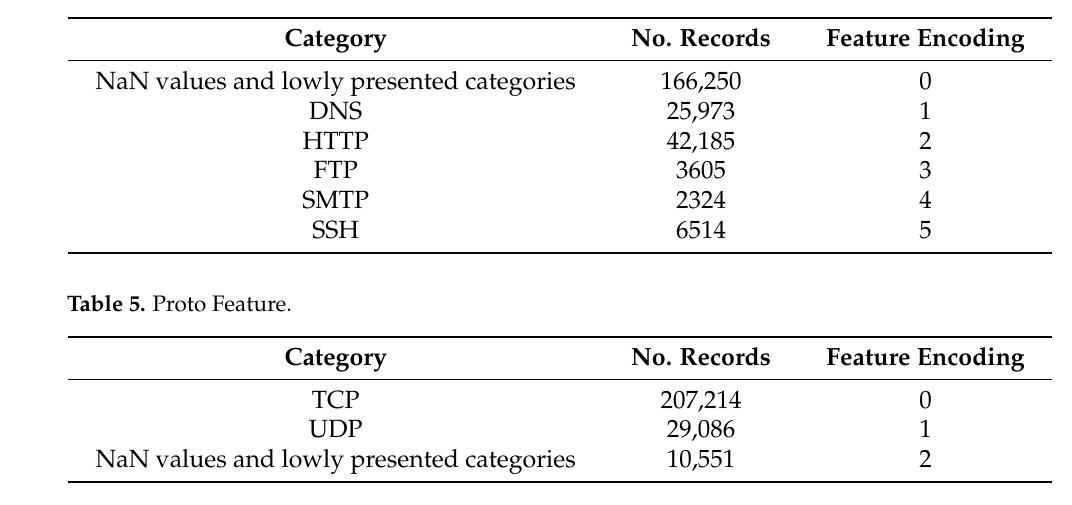
Table 4. Service Feature.